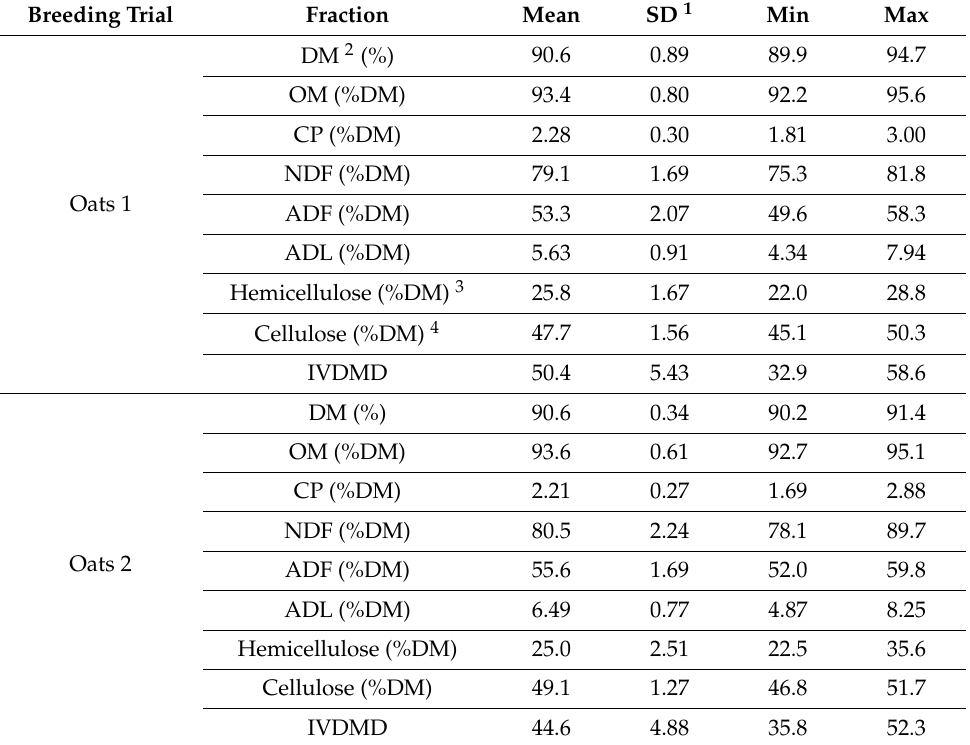
Table 1. Descriptive statistics of proximate composition of straw residues of 50 oats and 25 wheat genotypes from three breeding trials (Oats 1, advanced breeding lines and commercial varieties; Oats 2, commercial and historical varieties; Wheat, advanced breeding lines and commercial varieties). Breeding